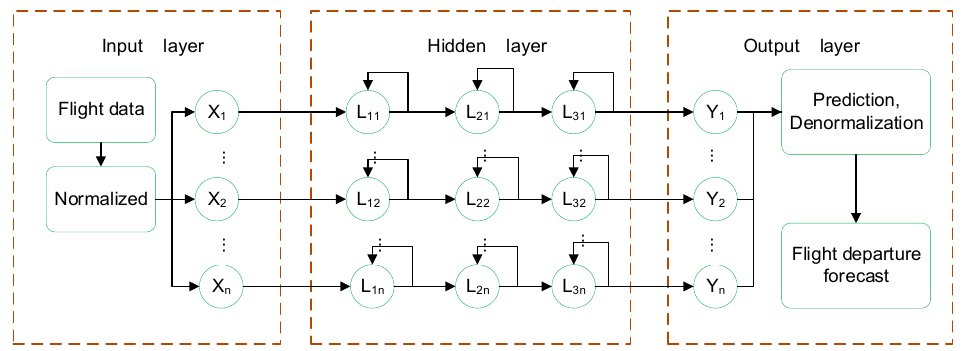
Figure 1. GRU network model diagram.